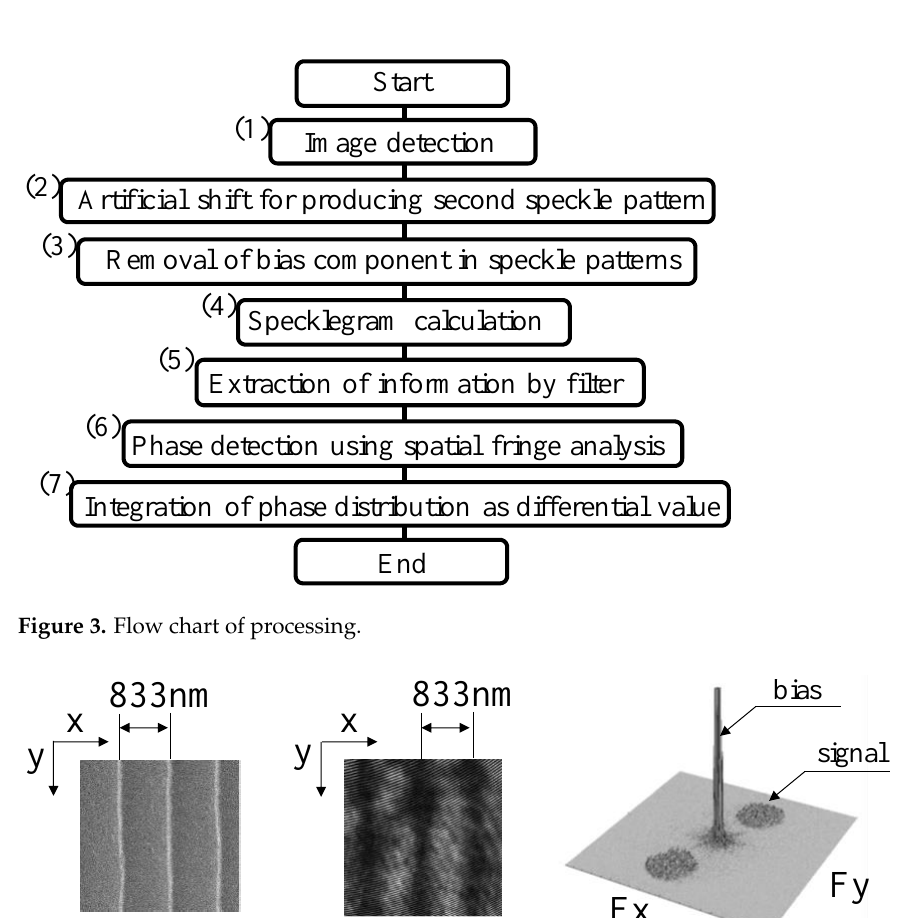
Figure 3. Flow chart of processing.